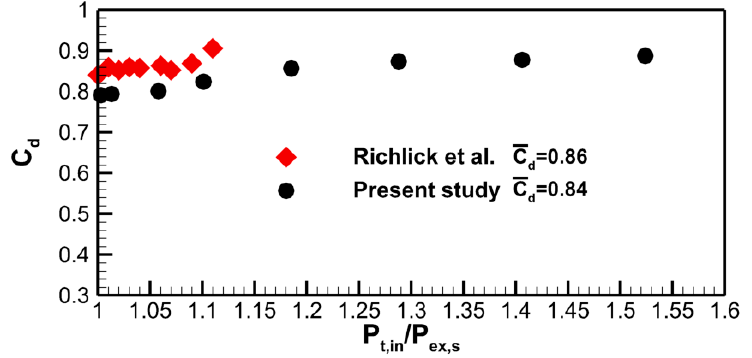
Figure 9. Discharge coefficients of jet holes for various pressure ratios: comparisons with the data from Richlick et al. [38].